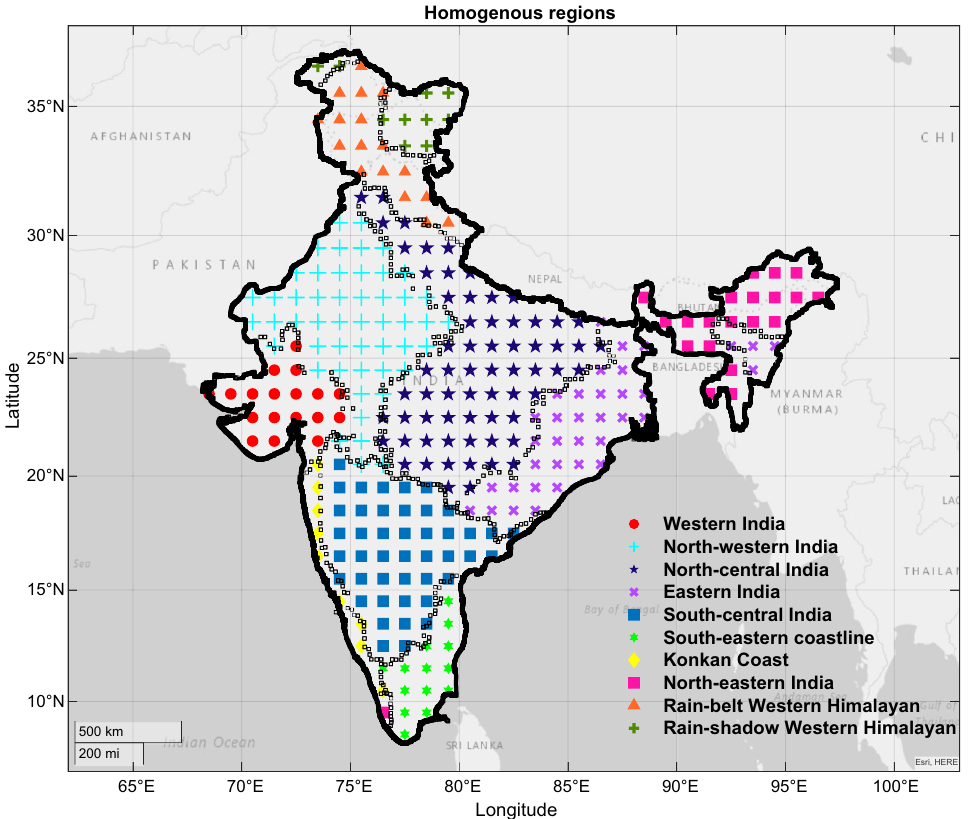
Figure 1. Geographical representation of grid points enclosed in each homogenous region. As per Koppen climate classification and accounting for the temporal variability of precipitation, Guntu et al. classified Western and North-western India as semi-arid and desert, North-central India as humid subtropical, Eastern India as tropical savannah, South-central India as semi-arid, South-eastern coastline as warm and humid subtropical, Konkan coast as tropical monsoon, North-eastern India as humid subtropical, North India (from Western Himalayas to Eastern Himalayas) has Alpine climate regime 31 . This figure is generated using Mapping Toolbox in MATLAB. (Ver 9.9 https:// in. mathw orks. com/ produ cts/ mappi ng.